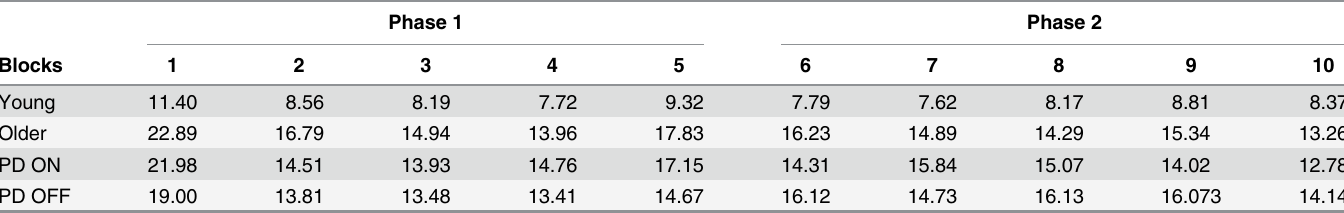
Table 2. Mean reading time in seconds for the non-repeated triads of all 10